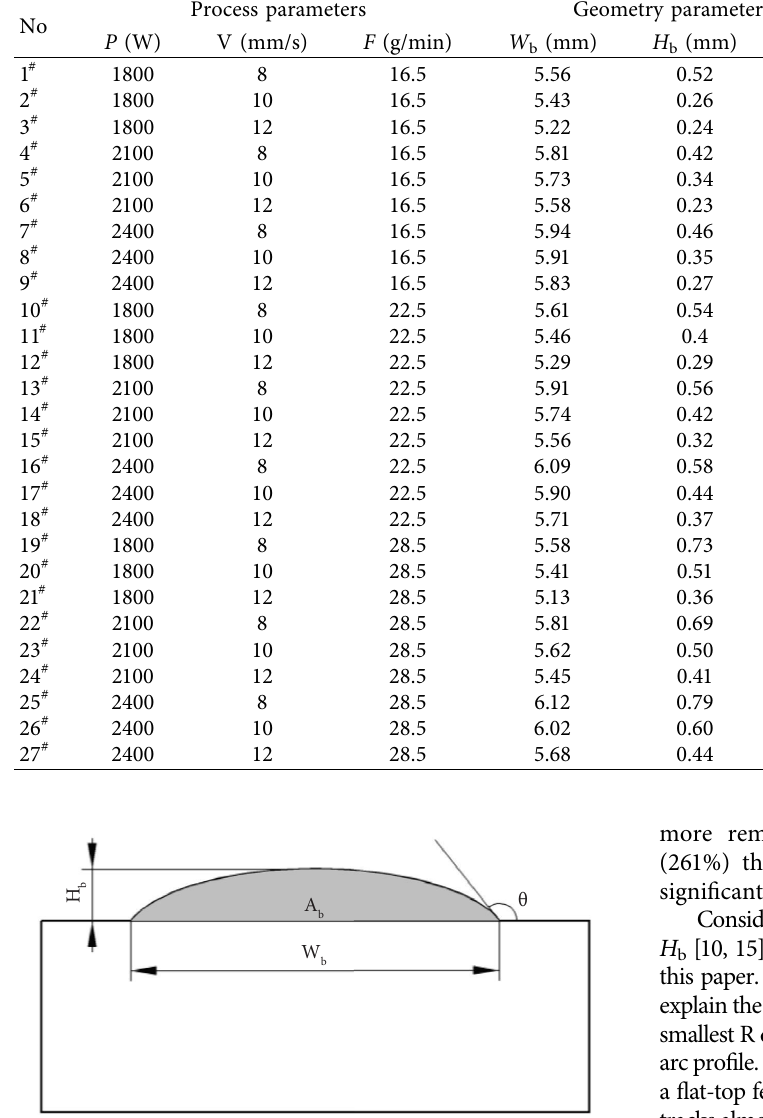
Figure 4: Schematic diagram of the track